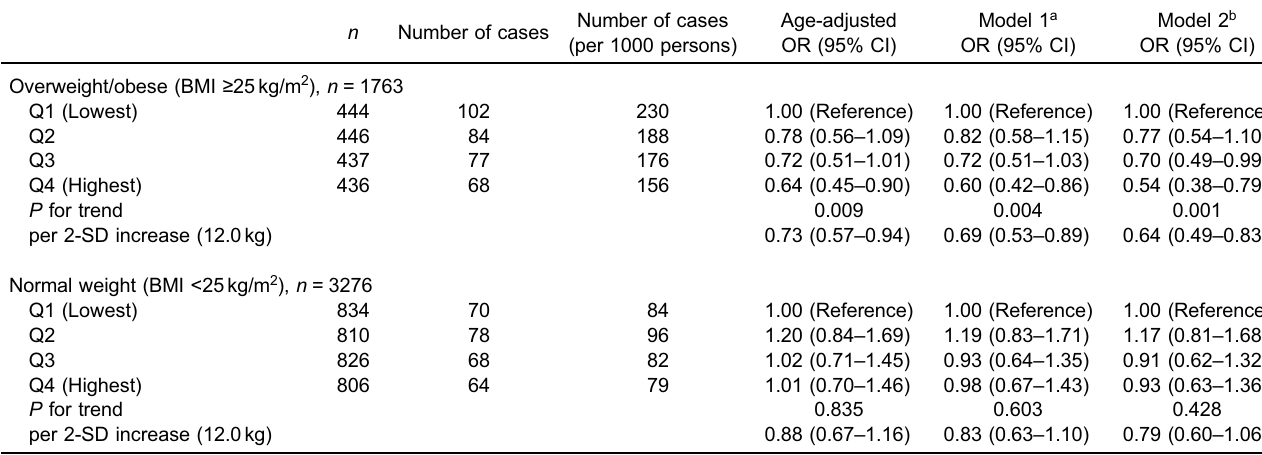
Table 5. Odds ratios for the prevalence of type 2 diabetes according to muscle strength categories in analysis strati fi ed by obesity